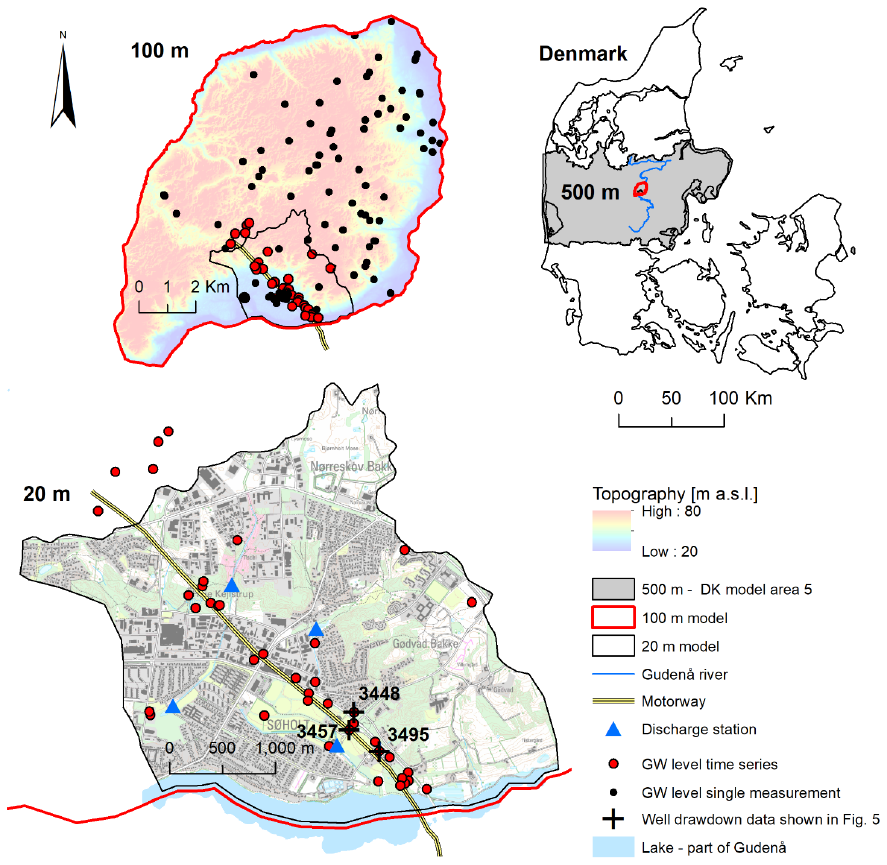
Figure 1. Location of the study area and nested hydrological models. Danish National Water Resources model, area 5 with 500 m grid ( top right ). The 100 m hydrological model ( top left ) and local hydrological model in the city of Silkeborg, with 20 m grid.